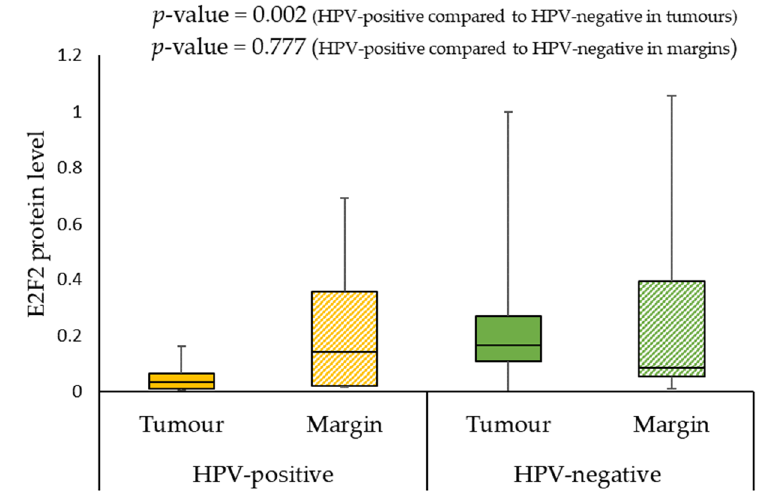
Figure 4. E2F2 protein level in HPV-positive compared to HPV-negative patients.